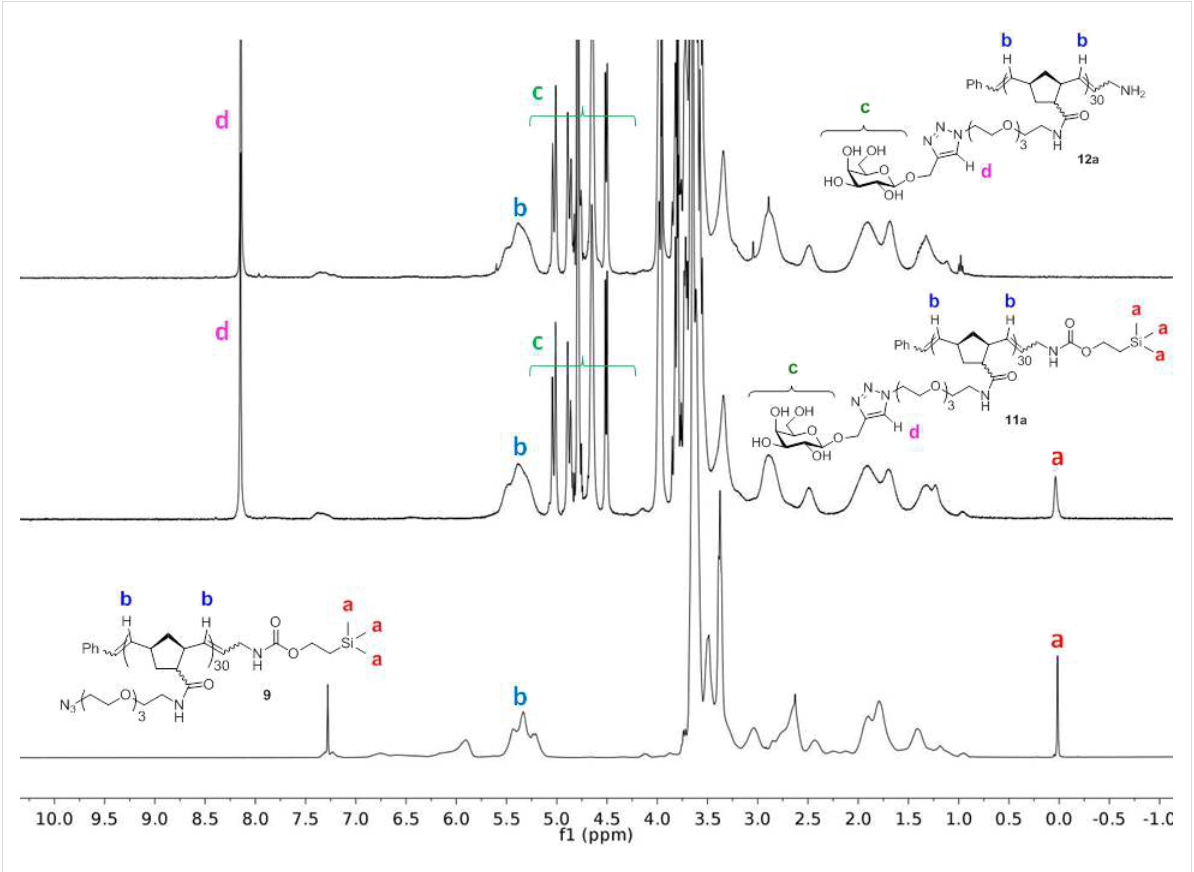
Figure 1: Overlay of 1 H NMR spectra of azido-polymer 9 (bottom) showing TMS protons – a and olefinic protons – b . Galactosyl glycopolymer 11a (middle) showing introduction of sugar protons – c and triazole protons – d . Amino-terminated galactosyl glycopolymer 12a (top) showing disappear- ance of TMS